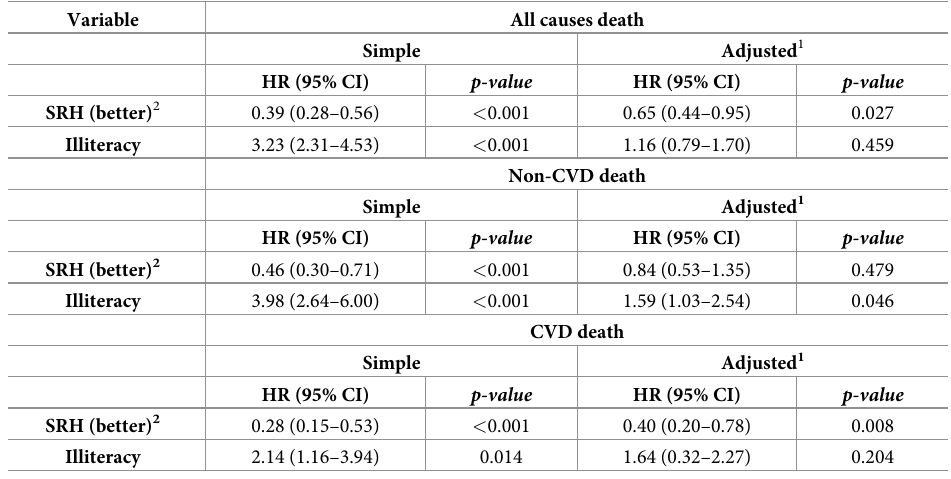
Table 3. Simple and adjusted cox proportional hazard models assessing self-rated health status and illiteracy as predictors of death from all causes, non-CVD deaths and CVD deaths. Variable